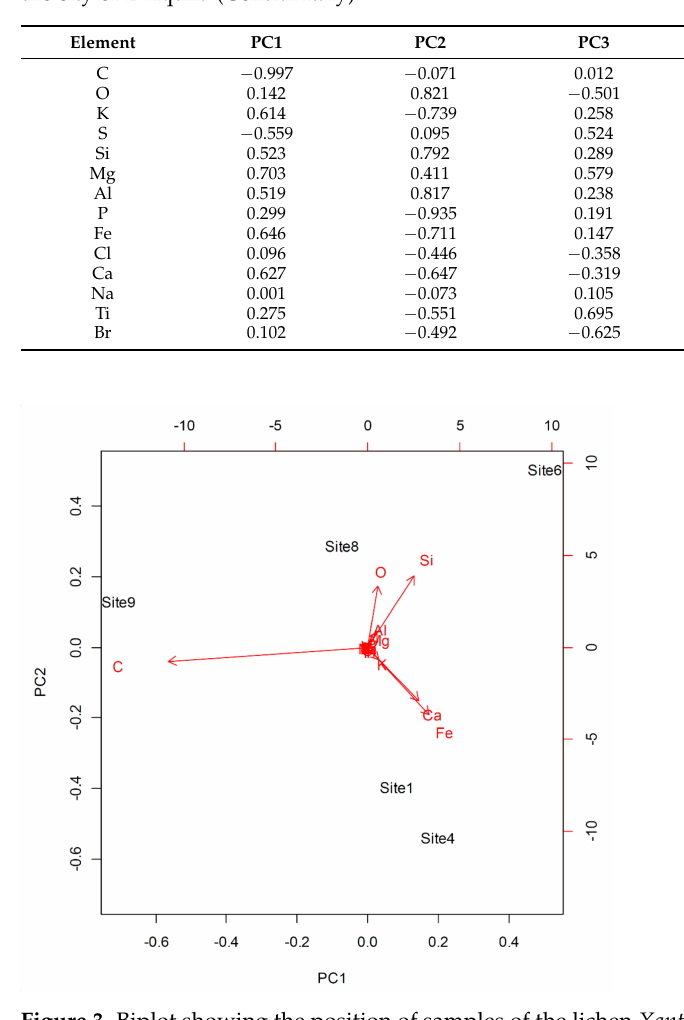
Table 4. Correlations for the Principal Components extracted for the chemical elements (in percent- ages) found on samples of the lichen Xanthoria parietina collected along an urban–rural gradient in the city of L’Aquila (Central Italy).